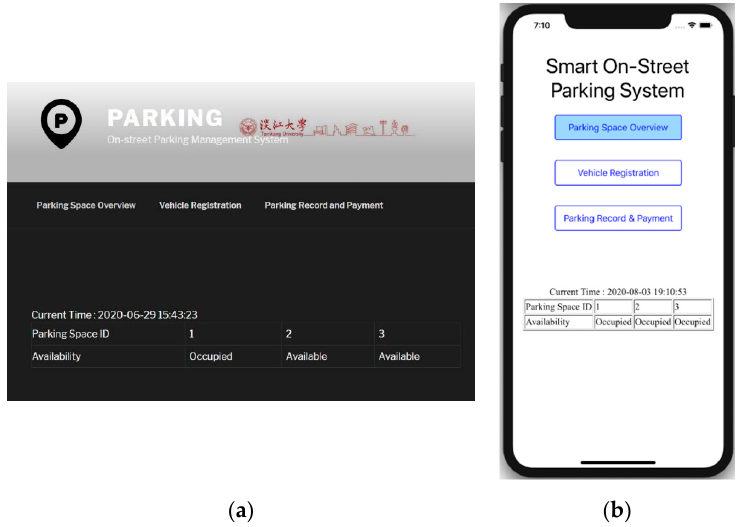
Figure 4. Parking Space Overview page showing availability of the parking spaces: ( a ) desktop web interface ( b ) iOS